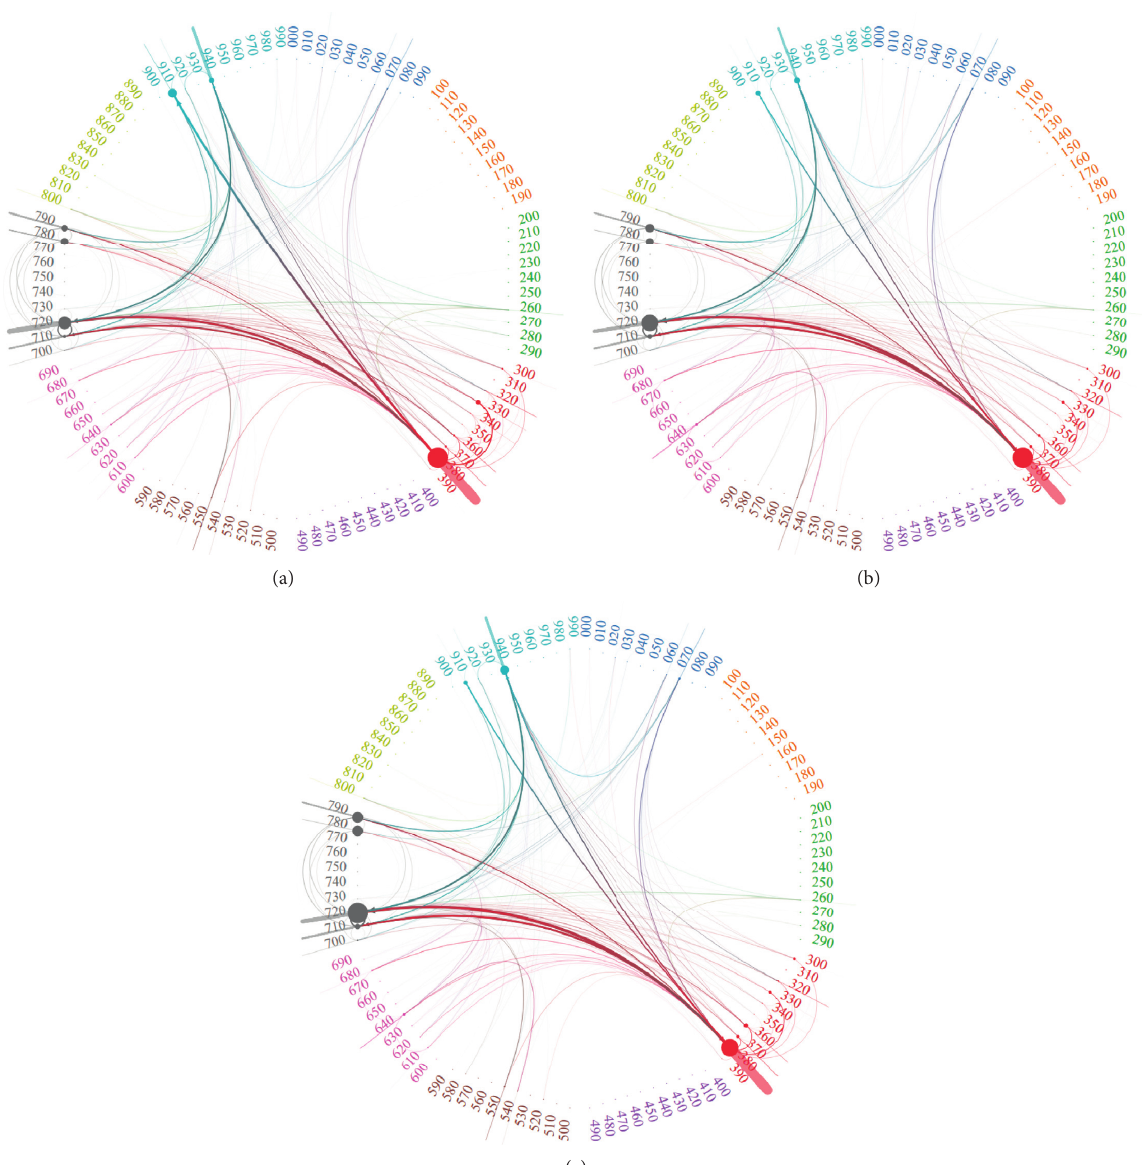
Figure 5: Visualizations of a TTN (top left) and two corresponding ATNs. The TNs are derived from the city wiki M¨unchen (https://www. muenchenwiki.de/wiki/Hauptseite) (see Section 4 for statistics about this wiki) using the procedural model of Section 3.2. Top right shows the ATN for which (co)authorship activities are estimated by means of Wikipedia (see Section 3.2.3). The ATN for which these activities are estimated via the wiki itself is displayed below. The visualizations are carried out by means of PolyViz [73] regarding the 2 nd level of the DDC: nodes are labeled (with numbers denoting the respective 2 nd level class) and colored to encode their membership to one of the top 10 DDC classes (see Appendix). The higher the weight of a topic, the larger the node, and the higher the weight of an arc, the thicker the line. Node and line sizes are defined relative to the maximum vertex and arc weights of the underlying